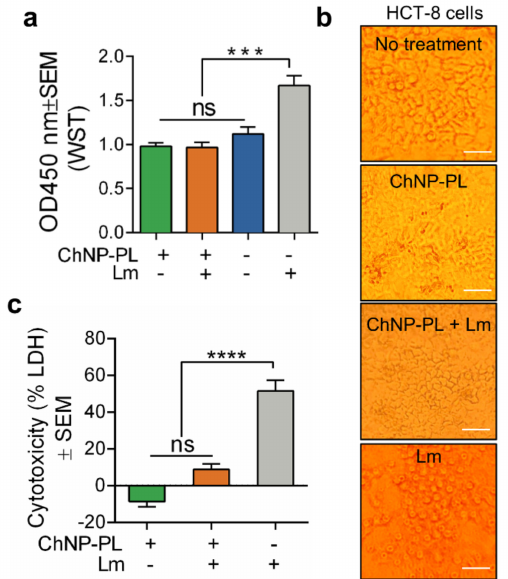
Figure 4. Cytotoxicity assessment of ChNP-PL on HCT-8, an intestinal epithelial cell line, using ( a , b ) water-soluble tetrazolium (WST-8) or ( c ) lactate dehydrogenase (LDH) assay. Cells were incu- bated with or without ChNP-PL (1:10 diluted) and L. monocytogenes F4244 (MOI 1:10; Lm:HCT-8) for 13 h and analyzed for cell proliferation or cytotoxicity. ( b ) Microscopic images of cell monolayers after the completion of the WST assay. None of the ChNP preparations caused any cell damage, except the positive control where cell monolayers received only Lm. Scale bars, 50 µ m. A pairwise Student’s t -test was used for statistical analysis. *** p < 0.0005, **** p < 0.0001, ns, non significant.